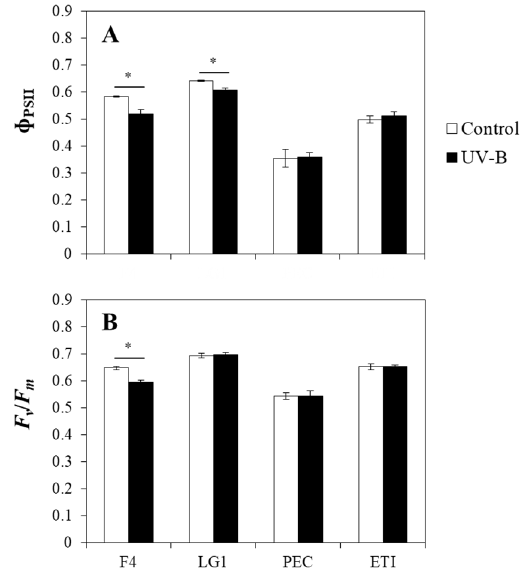
Figure 3. Effects of UV-B on the chlorophyll a fluorescence. The ( A ) actual ( Φ PSII ) and ( B ) maximum ( F v / F m ) efficiency of photosystem II (PSII) photochemistry were determined in control (bars in white) and UV-B treated (bars in black) microalgal strains (F4, LG1, PEC, and ETI). Measurements were performed at 18 h of treatment. UV-B exposure level was set at 1.7 W m − 2 supplemented with 70 μ mol m − 2 s − 1 photosynthetically active radiation (PAR). Control microalgal group only received PAR. Asterisks represent significant differences (* p < 0.05) between control and UV-B treatment within the same strain. Data are expressed as means of 6 different replicates ± standard deviation (SD). F4 and LG1: Chlorella sorokiniana strains; PEC: Pectinodesmus pectinatus strain; ETI: Ettlia pseudoalveolaris strain.